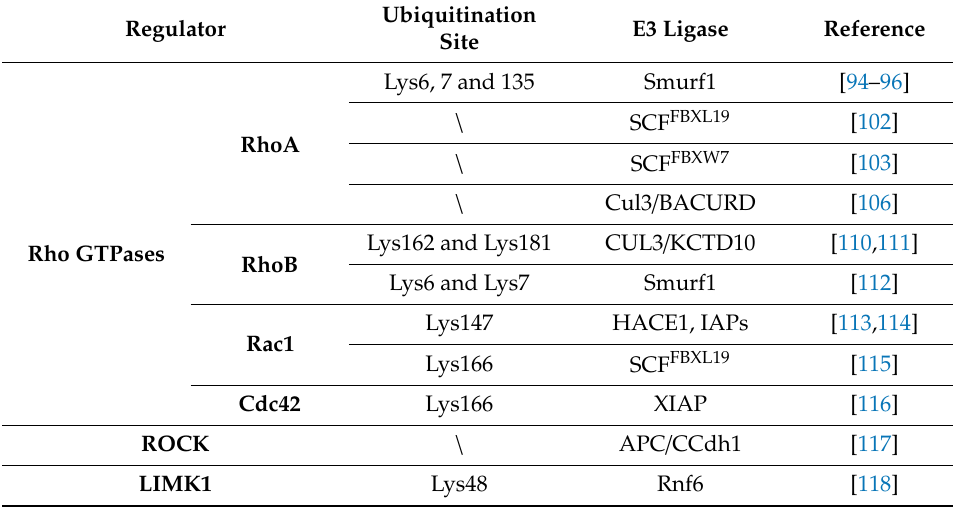
Table 2. E3s and ubiquitination sites of actin cytoskeleton